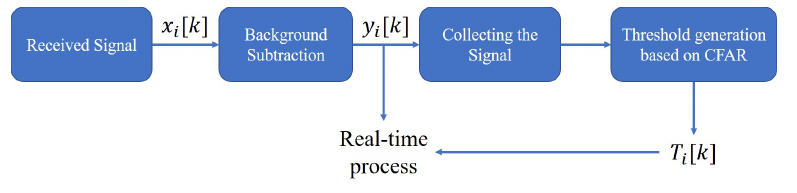
Figure 1. Basic signal